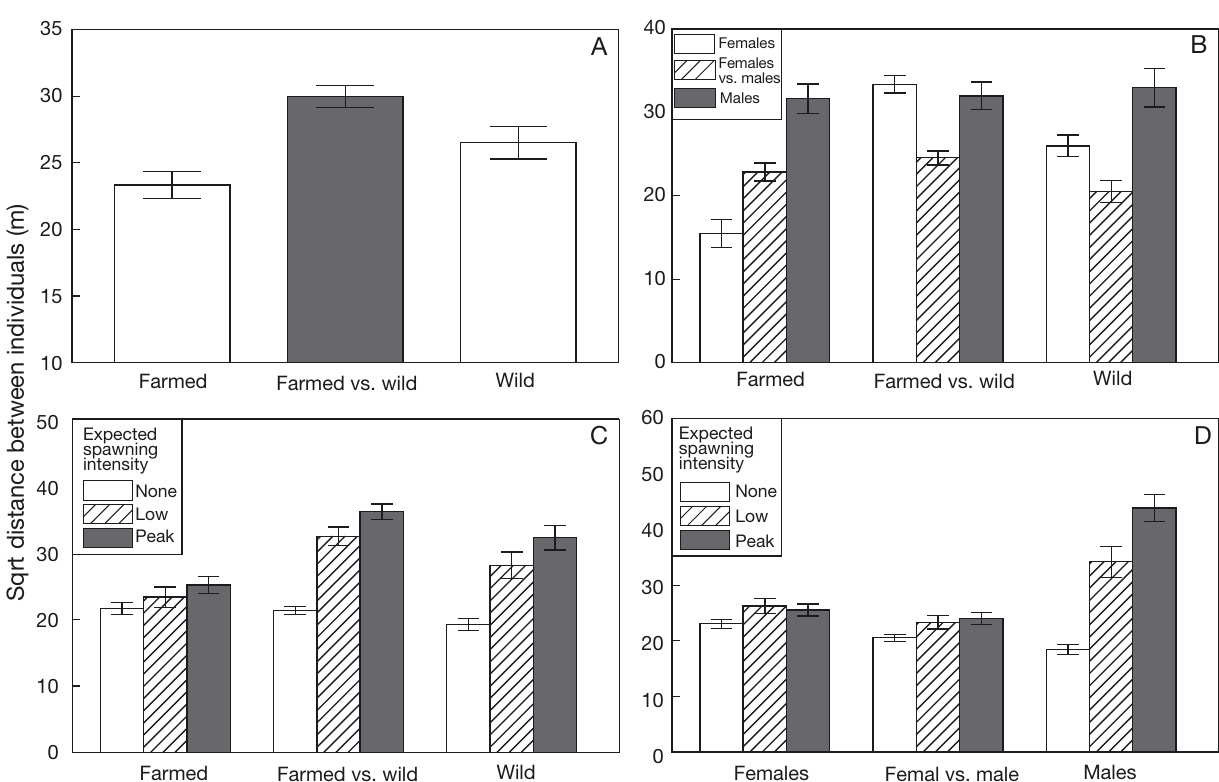
Fig. 4. Distance (A) between individuals of various origins, (B) across various origins and sexes, (C) across various origins and spawning intensities and (D) across sexes and spawning intensities. Values are adjusted means (±SE) from square root